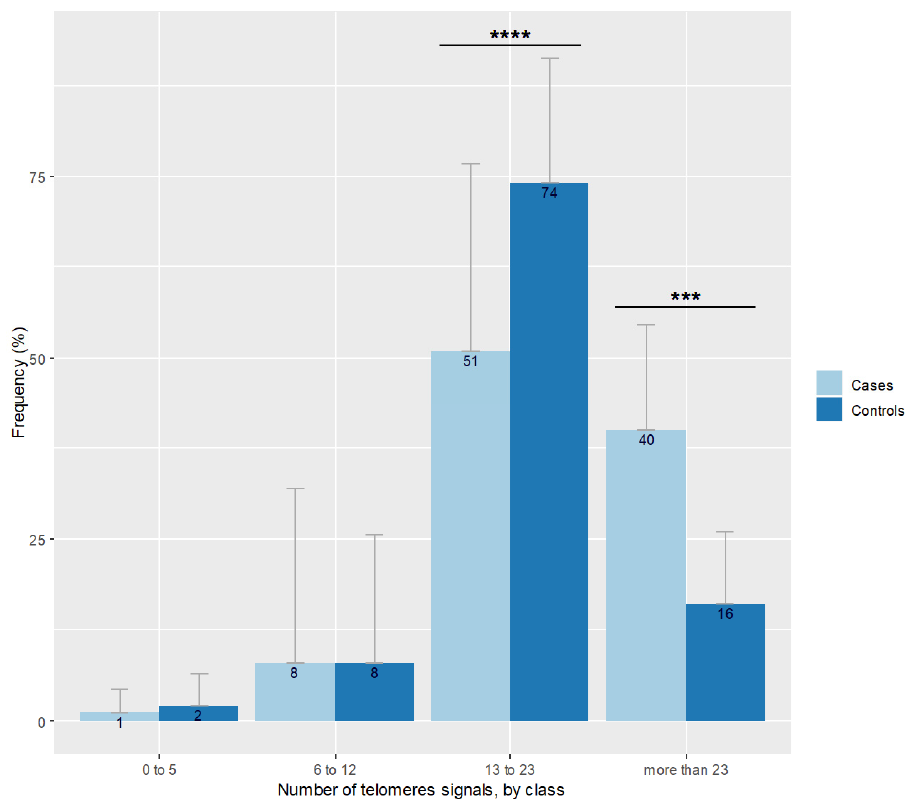
Figure 2. Number of telomere signals represented by class observed in spermatozoa of cases and controls. Bar plot represents the frequency of telomere signal number visualized in individual spermatozoon, classed with threshold at 5, 12, and 23 signals. Error bars show standard deviations. Cases are in pale blue and have more spermatozoa with more than 23 signals (*** p = 0.001), and less with 13 to 23 signals (**** p < 0.001) than controls represented in dark blue.